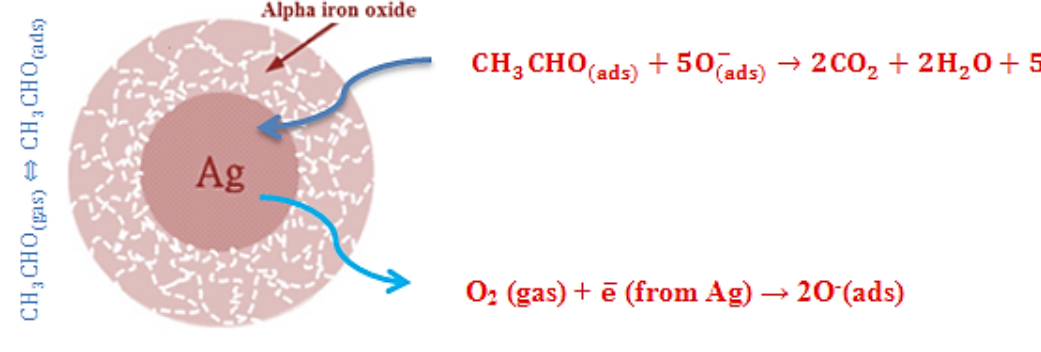
Figure 10. Possible ethanol sensing mechanism by Ag@ α -Fe 2 O 3 core–shell nanocomposites (according to